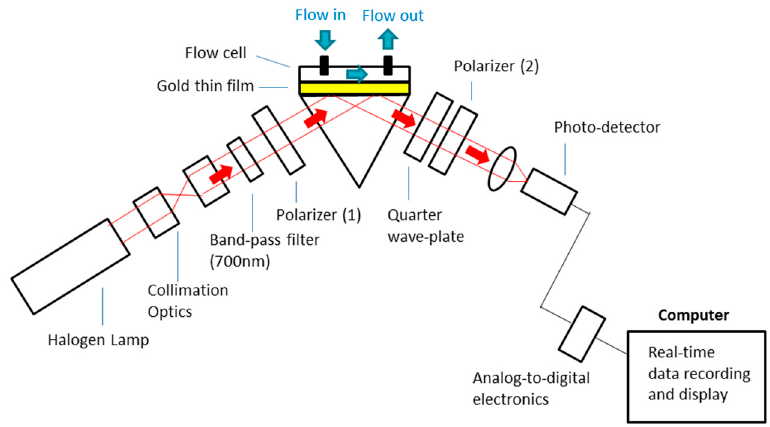
Figure 1. Experimental set-up of the phase-intensity surface plasmon resonance (SPR) biosensor.